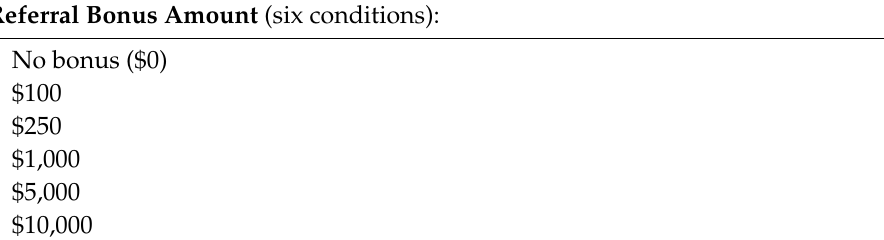
Table 1: The 24 varying conditions comprising the experimental vignette study. Referral Bonus Amount (six